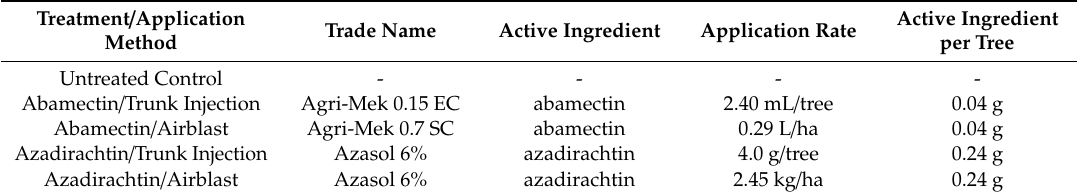
Table 1. Treatment rates for pear trunk injection and airblast application comparison at the Trevor Nichols Research Center, Fennville, MI in 2017 and